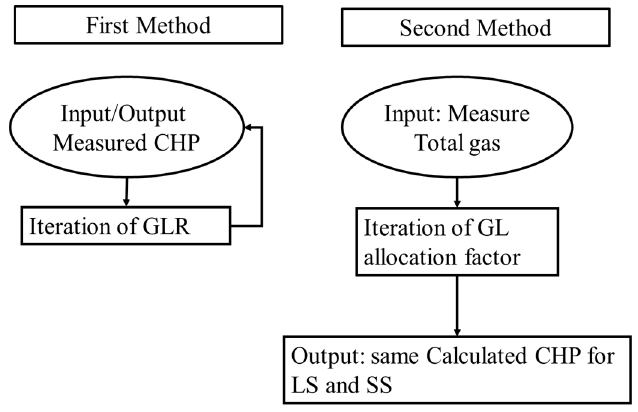
Figure 2. Workflow comparison between two methods proposed by PETEX.